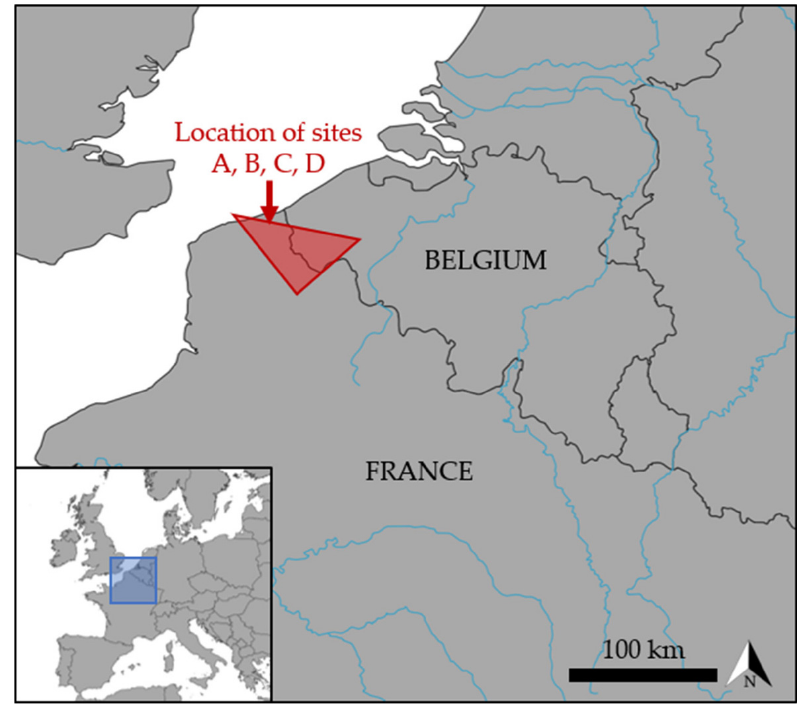
Figure 2. Location of the four sites treated with enzyme-based